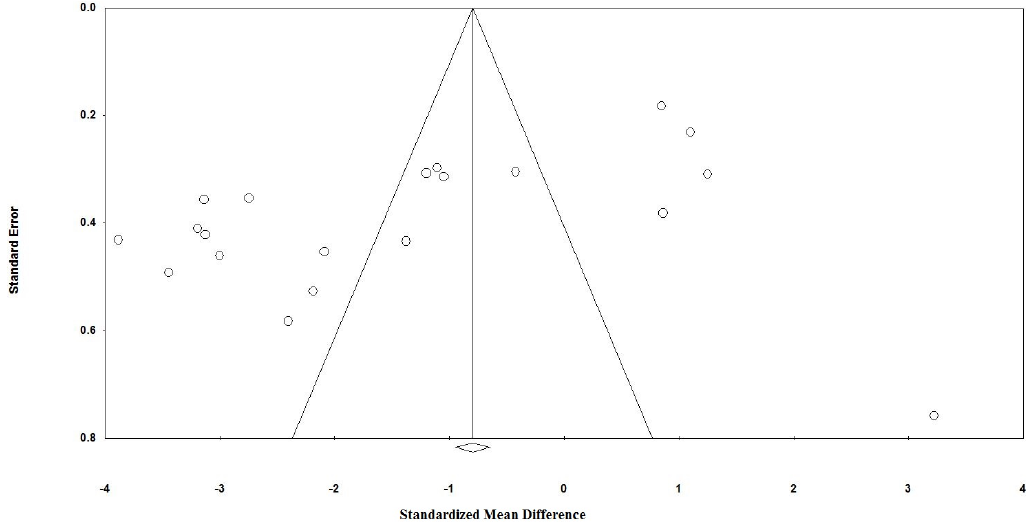
Figure 3. Funnel plots detailing publication bias in the studies selected for analysis. Open circles represent observed published studies; open diamond represents observed effect size.